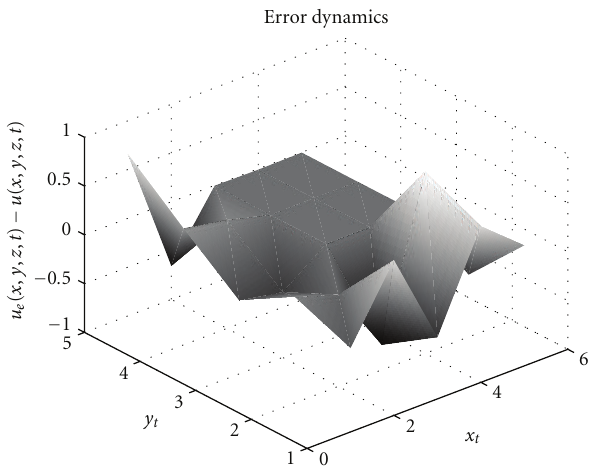
Figure 8: Error of the approximation. Di ff erence between 3D PDE numerical solution and 3D DNN approximation at time 46 days along the whole domain.